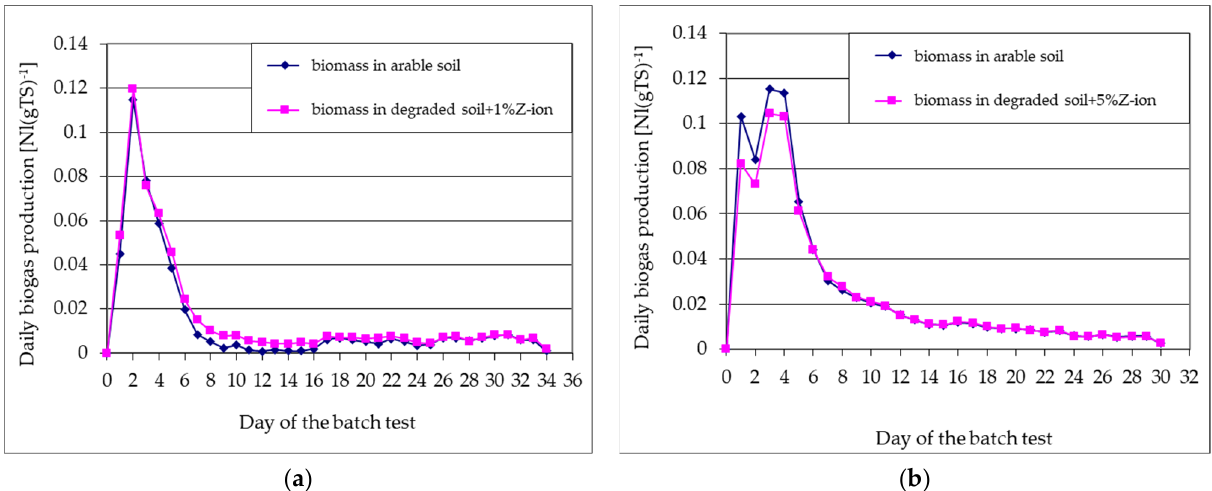
Figure 1. Daily biogas production for ( a ) the cocksfoot biomass obtained in arable soil and degraded soil supplemented with a 1% Z-ion addition, and ( b ) the maize biomass obtained in arable soil and degraded soil supplemented with a 5% Z-ion addition (values presented as means, n = 3).